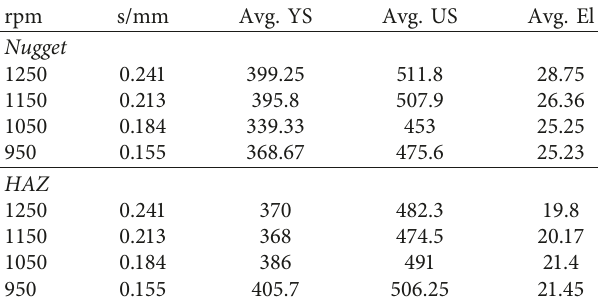
Table 10: Yield strength, ultimate strength, and elongation ex- perimental responses performed along the steepest ascent direction (summarized data for nugget and HAZ).